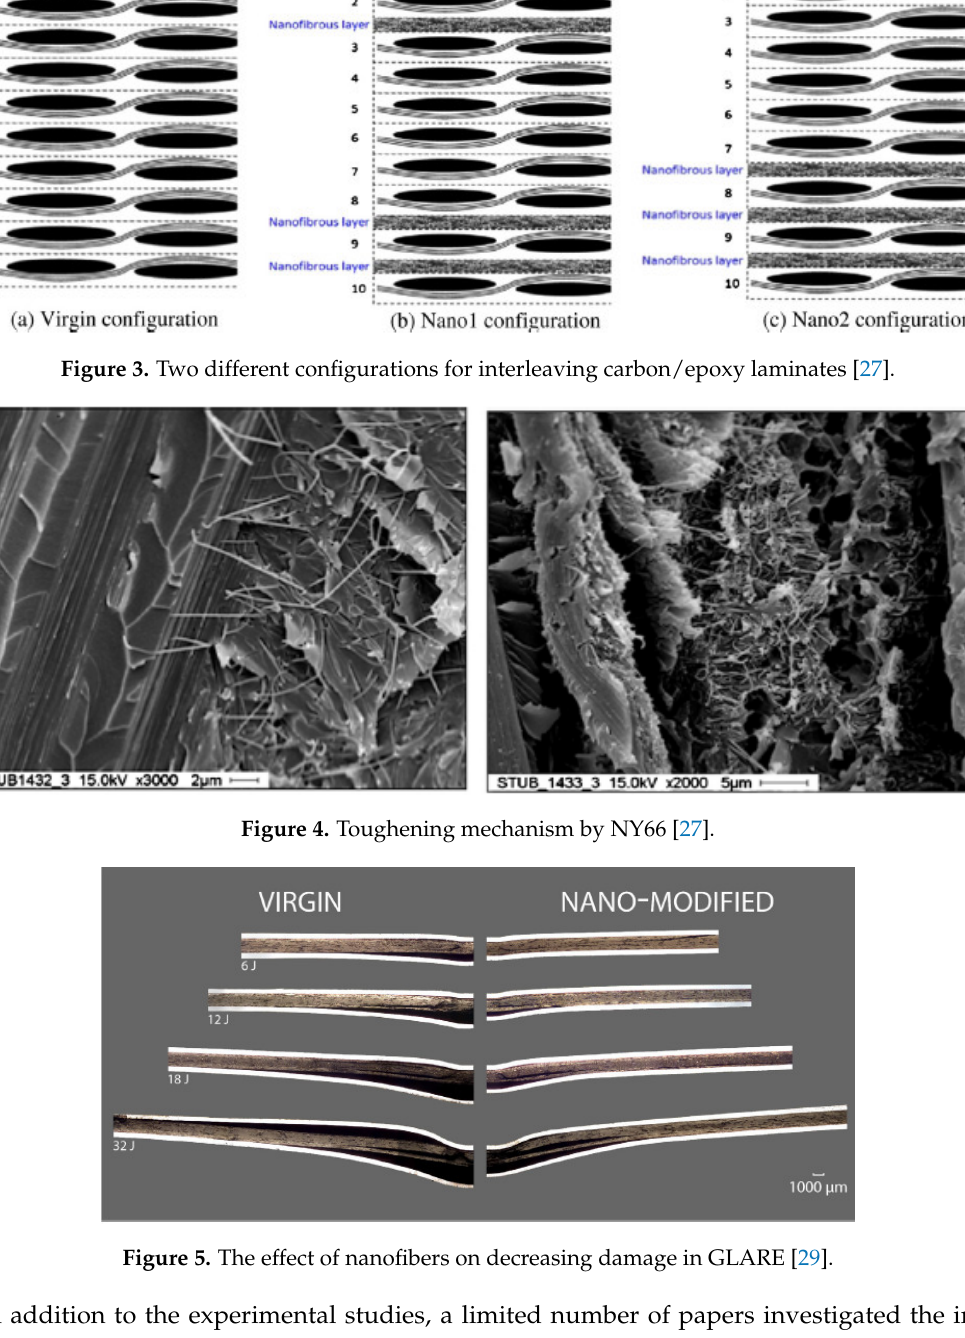
Figure 6. Different interleaf sequences used for considering their effect on delaminated area (blue areas belong to reference layer and red areas belong to nano-modified layer) [19] .